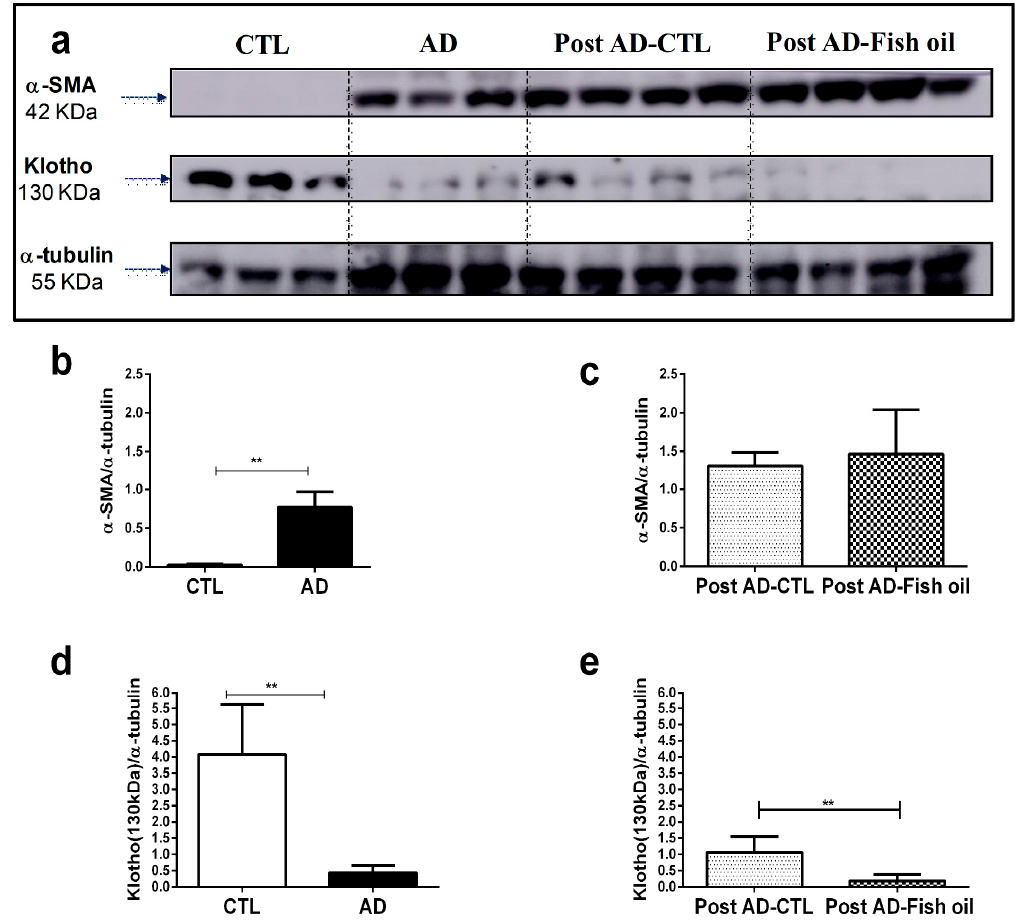
Figure 4. Klotho and alpha smooth muscle actin ( α -SMA) expression by Western blot: ( a ) α -SMA and Klotho expression in renal tissue, normalized by α -tubulin in the CTL, AD, Post AD-CTL, and Post AD-Fish oil groups. Relative quantification of α -SMA ( b , c ) and Klotho ( d , e ) in the CTL, AD, Post AD-CTL and Post AD-Fish oil groups (** p < 0.01).